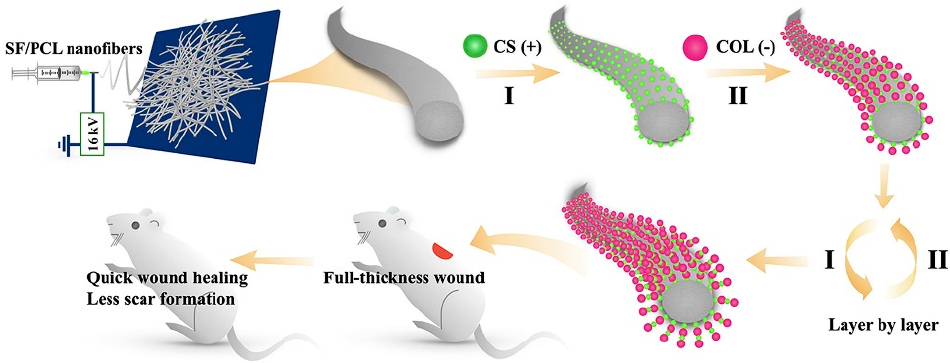
Figure 2. The preparation process of modified nanofibrous mats. The electrostatic spinning technique was applied to fabricate SF/PCL nanofiber mats. Positively charged CS and negatively charged collagen type I (COL) were deposited on the nanofiber mats by the layer-by-layer self-assembly technique. Reprinted with permission from [49]. Copyright (2020) Elsevier.